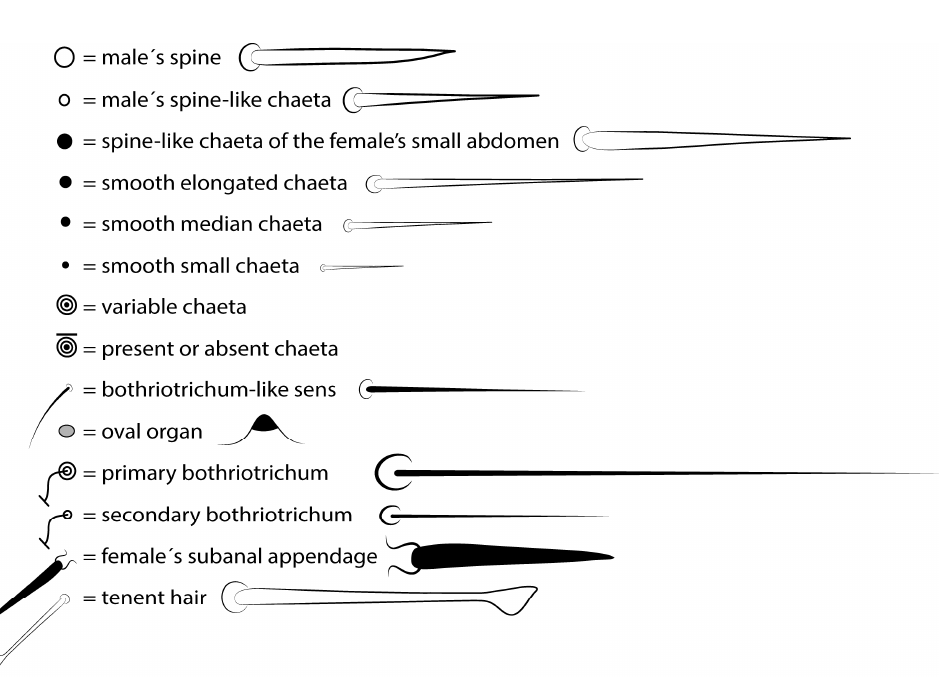
5 of 43 Diagnosis: Both sexes with the same color pattern, with head with a longitudinal